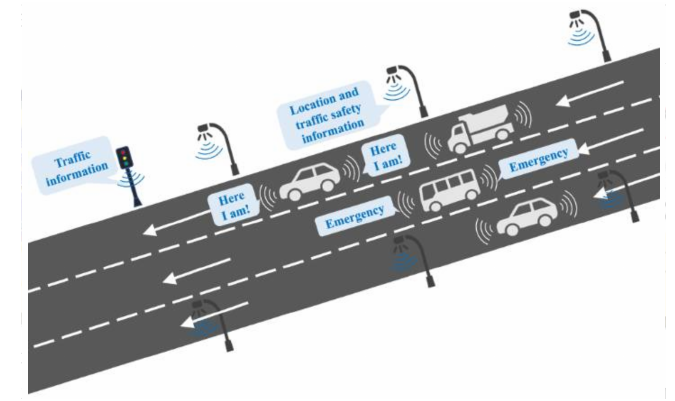
Figure 2. Intelligent transportation